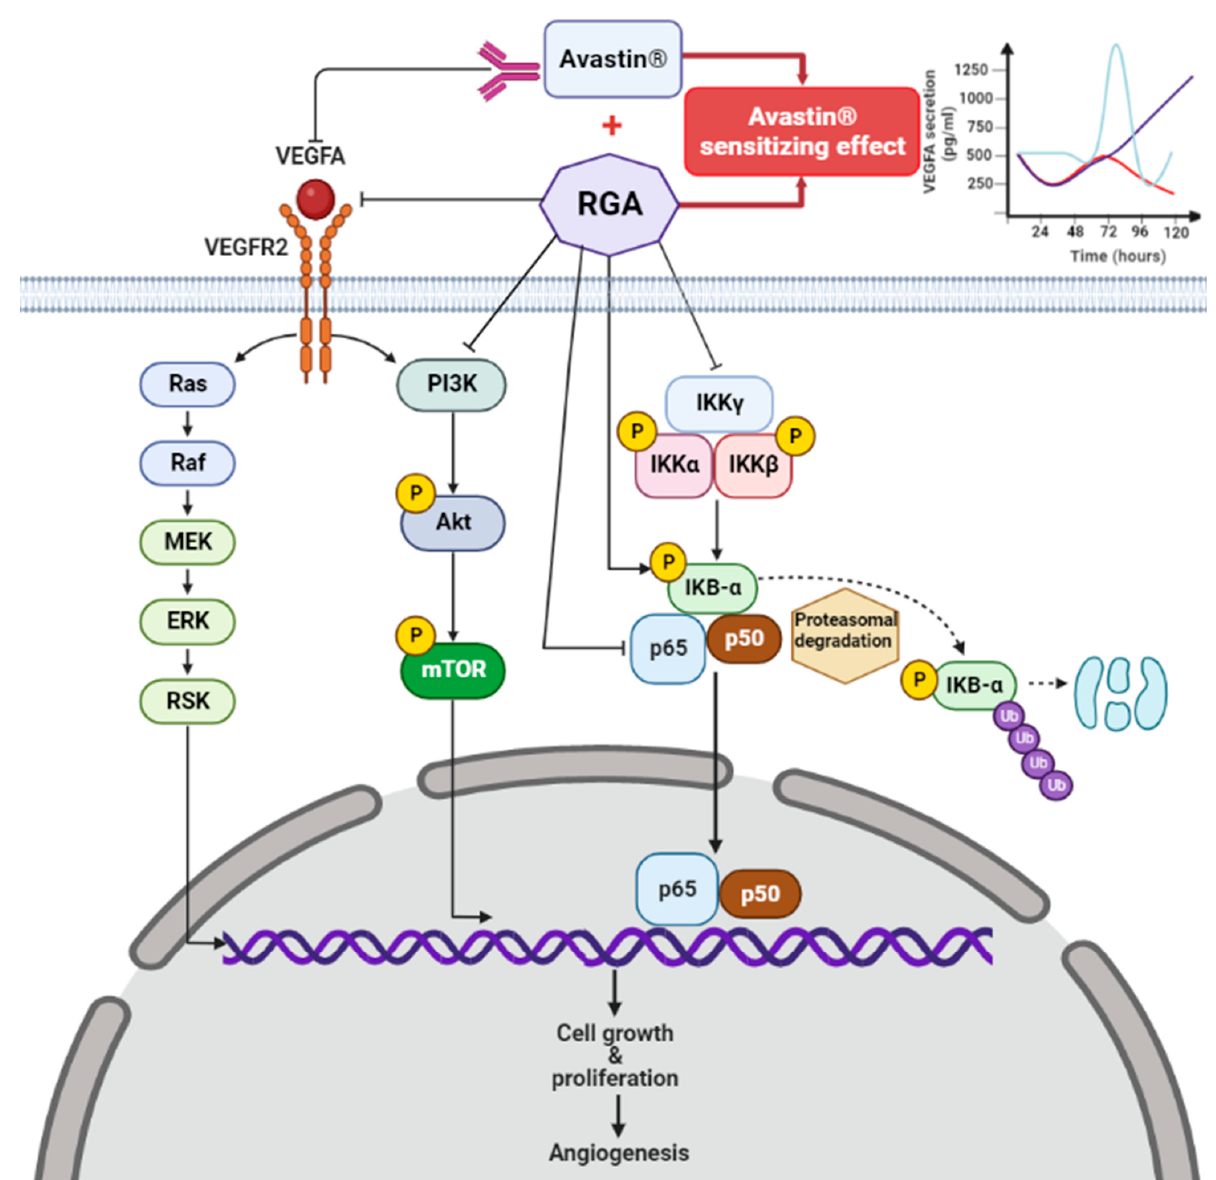
Figure 7. Schematic illustration of the novel proposed mechanisms of the anti ‐ angiogenic impact of Resvega ® (RGA), which is able to target several angiogenesis molecular pathways in human ARPE ‐ 19 retina cell model. RGA counteracts angiogenic VEGF ‐ A production through an alteration of the AKT/PI3K and NF κ B pathways. In detail, RGA reduces the regulator complex IKK controlling the downstream NF κ B subunits P65 and P50 belonging and their nuclear/cytosolic localization. This new RGA ‐ targeted pathway complements data on the impact of RGA, which we have previously demonstrated to be involved in preventing activation of the MAPK signaling pathway in ARP19 cells [22] . The disruption of these two important angiogenesis signaling pathways likely leads to a sensitization of retina cells to the anti ‐ VEGF treatment, resulting in an increased ability of Avastin ® to decrease VEGF ‐ A secretion over time.